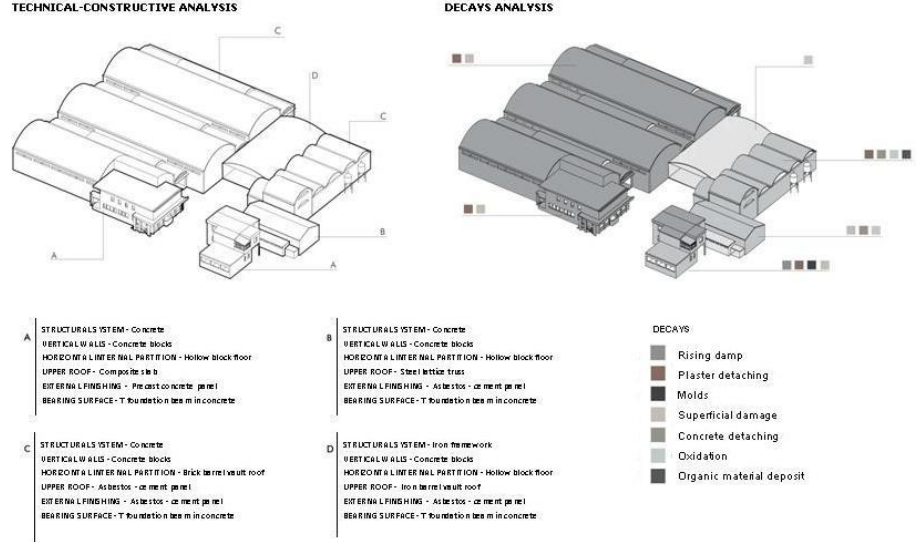
Figure 6. Technical constructive analysis ( left side); decays analysis ( right side).